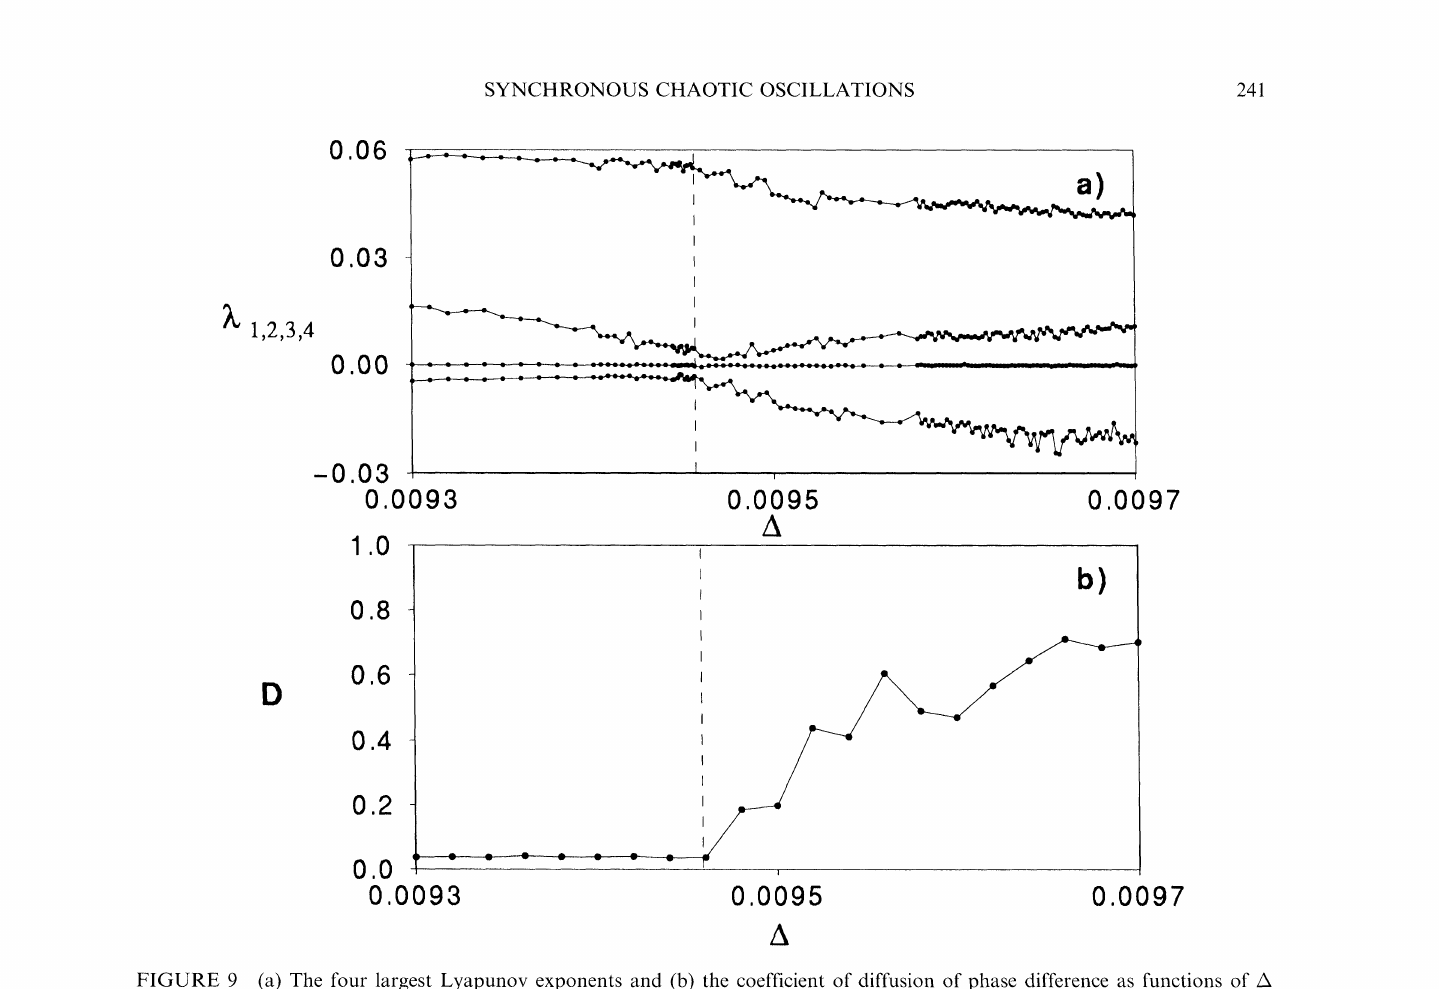
FIGURE 9 (a) The four largest Lyapunov exponents and (b) the coefficient of diffusion of phase difference as functions of A at # 7.2 (direction b in Fig.